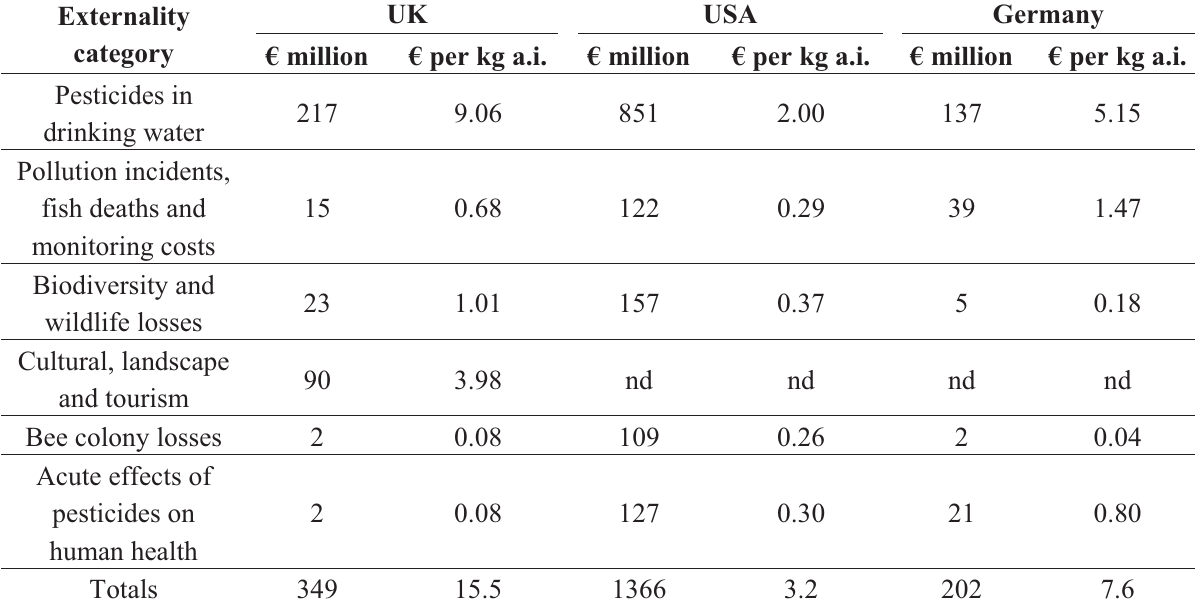
Table 3. Externalities of pesticides for UK, USA and Germany, 2005 – 06. Source: [31]. UK USA Externality category